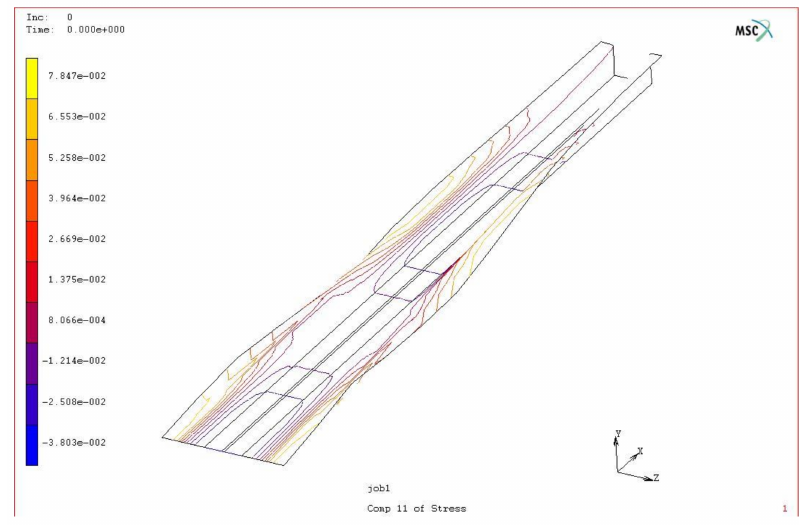
Figure 9. A contour diagram of the mean longitudinal strain from the 1st to 12th rack.